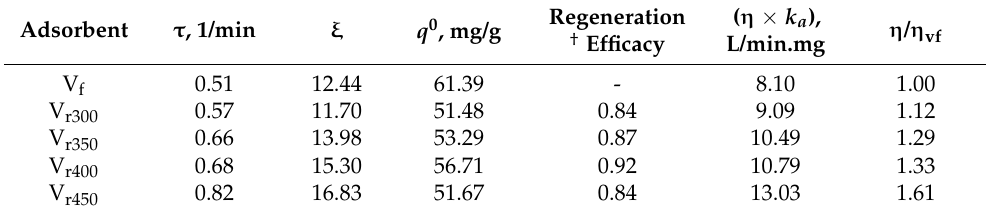
Table 1. Parameters of Equation (1) and relative effectiveness factor obtained from breakthrough curves *.